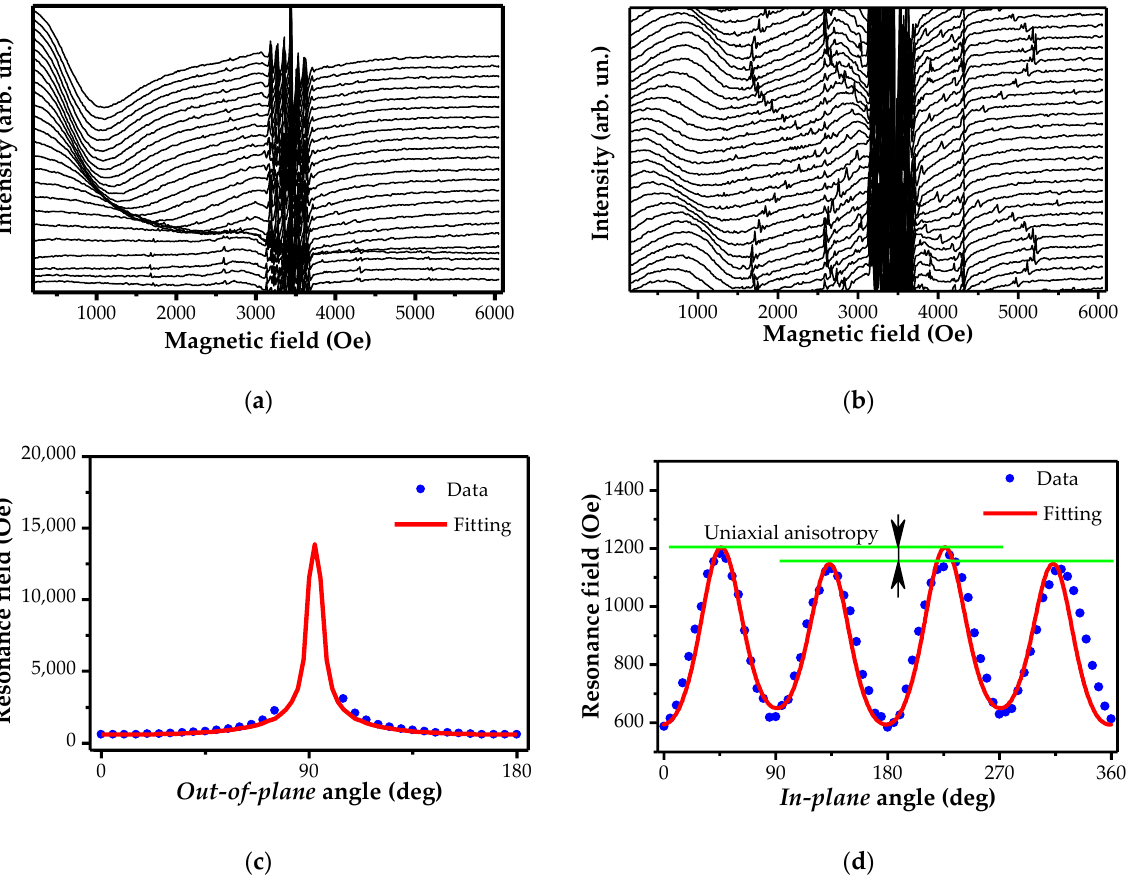
Figure 5. Orientational dependent magnetic resonance spectra of Fe-ion-implanted MgO recorded at RT in: ( a ) out-of-plane geometry; ( b ) in-plane geometry. Angular dependencies of FMR resonance field in: ( c ) out-of-plane geometry; ( d ) in-plane geometry.